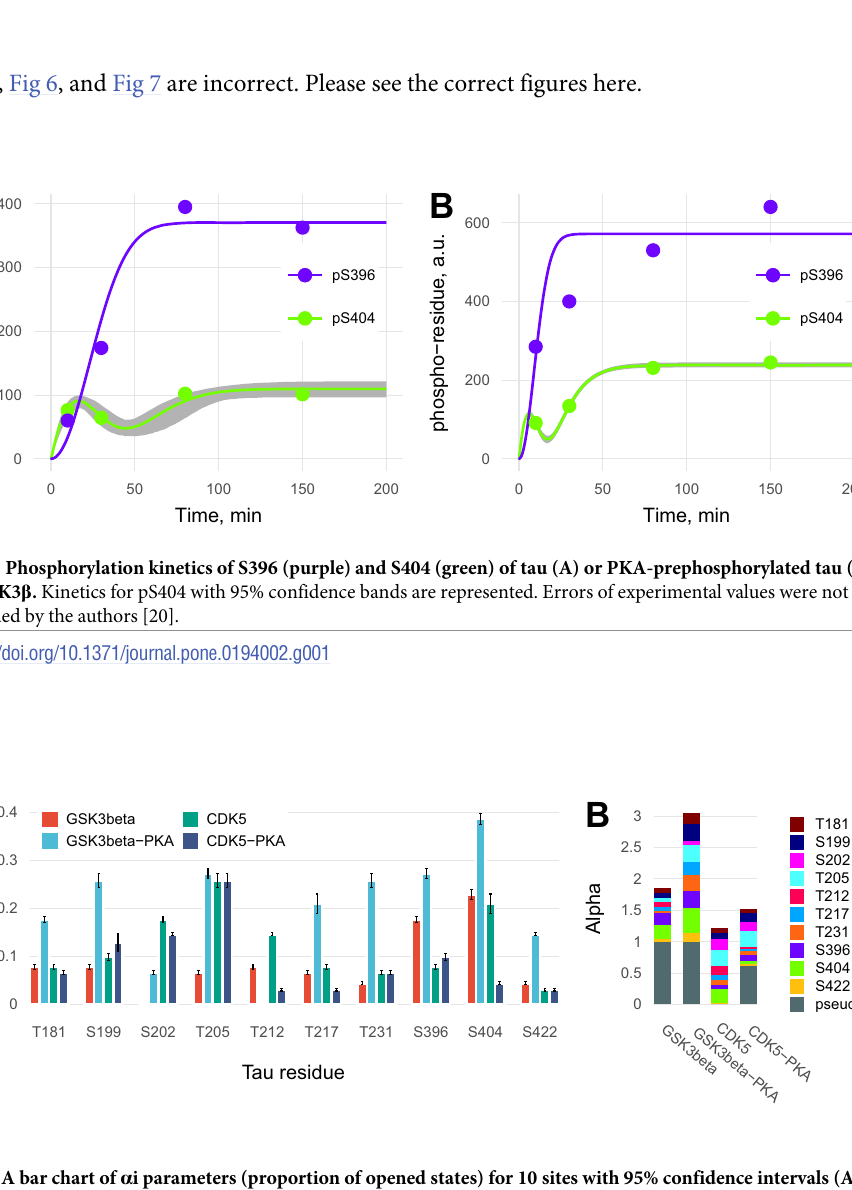
Fig 6. A bar chart of α i parameters (proportion of opened states) for 10 sites with 95% confidence intervals (A), and a stacked bar chart for the same sites including a pseudo-residue